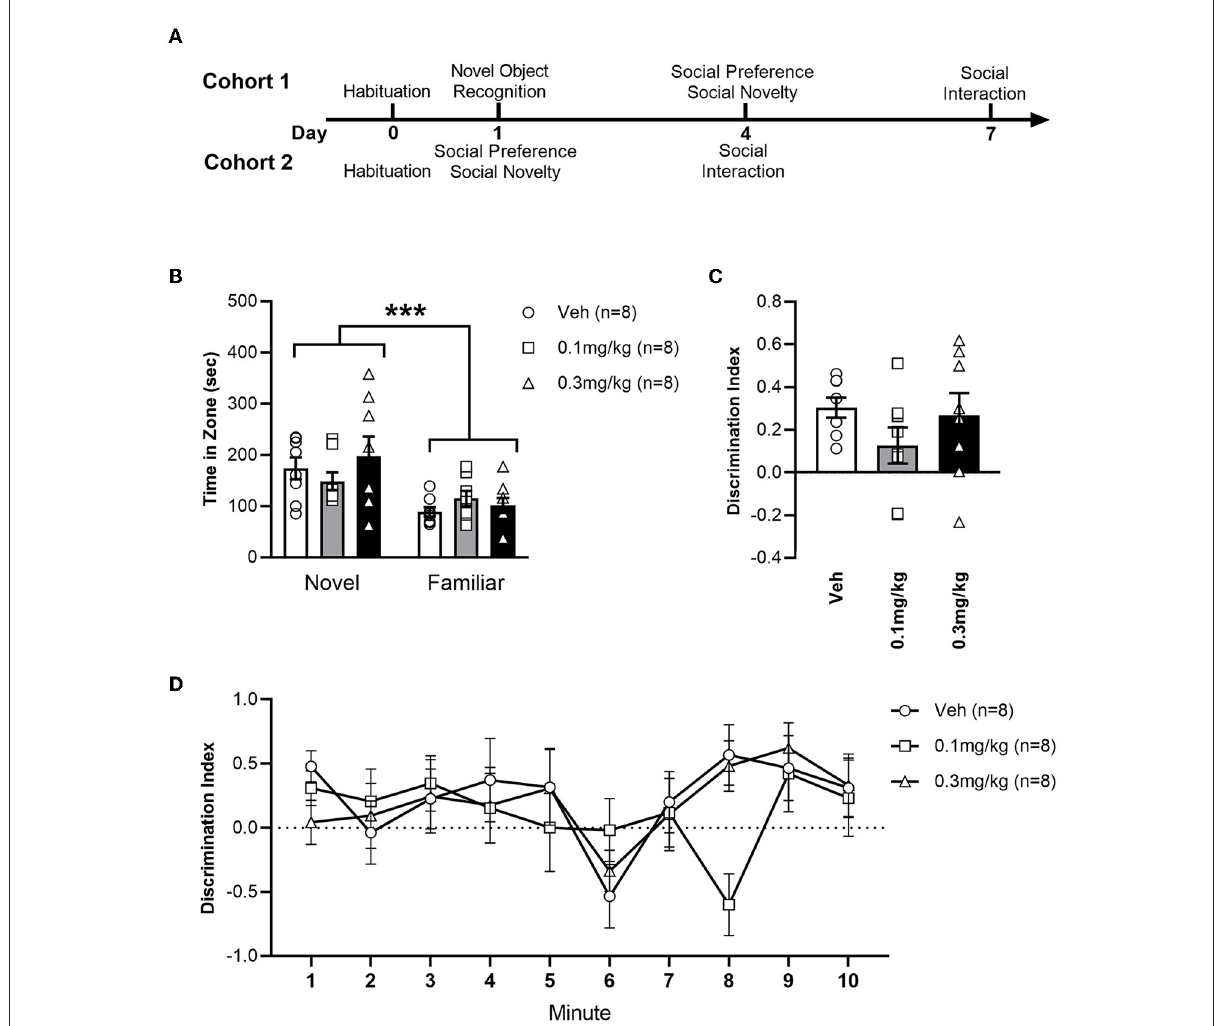
FIGURE1 (A) Timeline of experiments in cohorts 1 and 2. (B) Average time ( + /- SEM) spent exploring the novel or familiar object zone in LH rats treated with vehicle (white bar), 0.1 mg/kg URB597 (gray bar) and 0.3 mg/kg URB597 (black bar), with individual values displayed as circles, squares